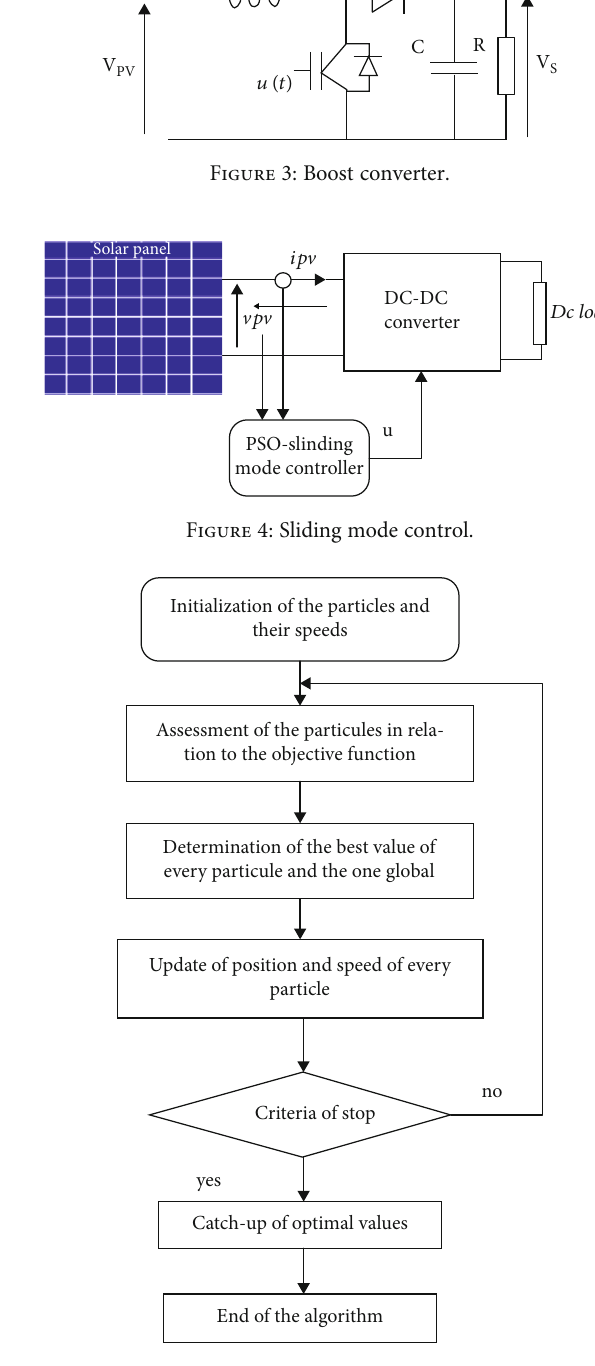
Figure 5: Flowchart of the PSO algorithm.